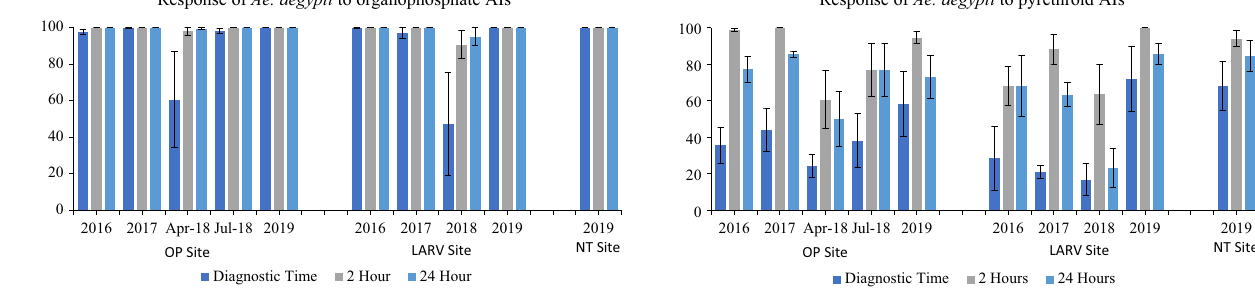
Fig. 4 Mean response and 95% confidence interval of Pasco County Aedes aegypti field populations in response to pyrethroid active ingredients in the CDC bottle bioassay. For each population and each time point, the percent mortality at the diagnostic time, at 2 h, and 24 h is